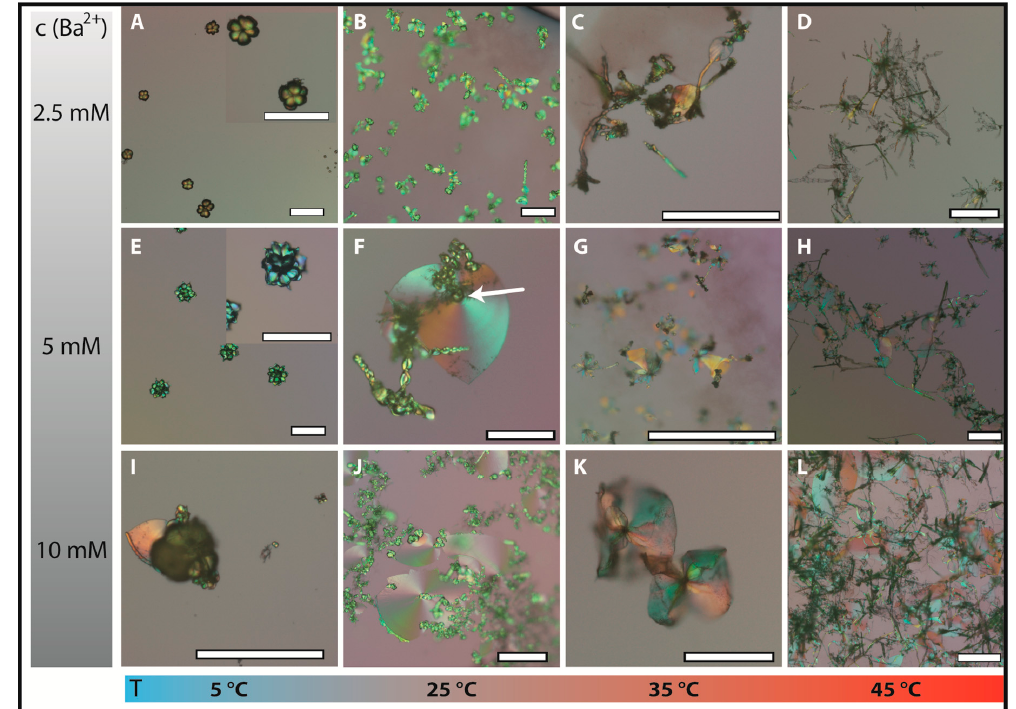
Figure 2. ( A–L ) PLM images of typical biomorphic morphologies obtained at varying barium concentrations and temperatures (as indicated) after a growth period of 12 h using a silica solution with [SiO 2 ] = 8.9 mM and an initial pH of 11.3 (determined at 25 °C before mixing with barium chloride solution). Note the presence of peculiar 3D trumpetlike shapes in ( G ), as visualised by the optical depth of field. The arrow in ( F ) indicates a closed globular particle, from which a polycrystalline sheet-like aggregate has emerged. Scale bars are 200 µm.